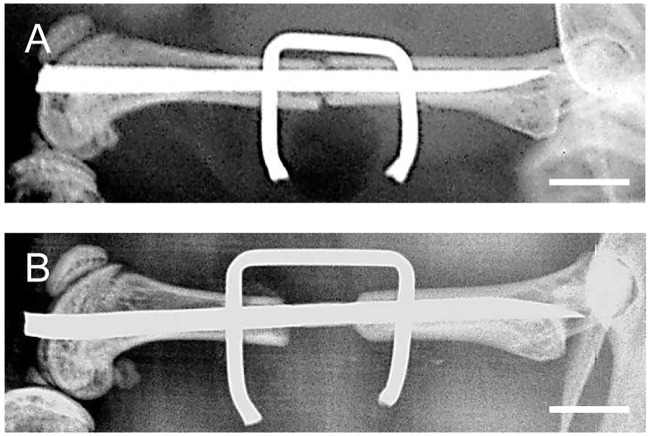
Radiological analyses of osteotomized femurs at day 7 after surgery.A, B: X-rays of the osteotomized mouse femurs with a segmental defect of 0.25 mm (A) or 1.8mm (B) stabilized by the ‘pin-clip’ technique at 7 days after surgery. The bone fragments in the Union group (A) have direct contact, whereas bone fragments of the Nonunion group (B) presented with a persistent gap. As expected, no radiological signs of osseous bridging can be observed at this early 7-day time point. Images do not show signs of implant dislocation. Bars represent 2 mm.